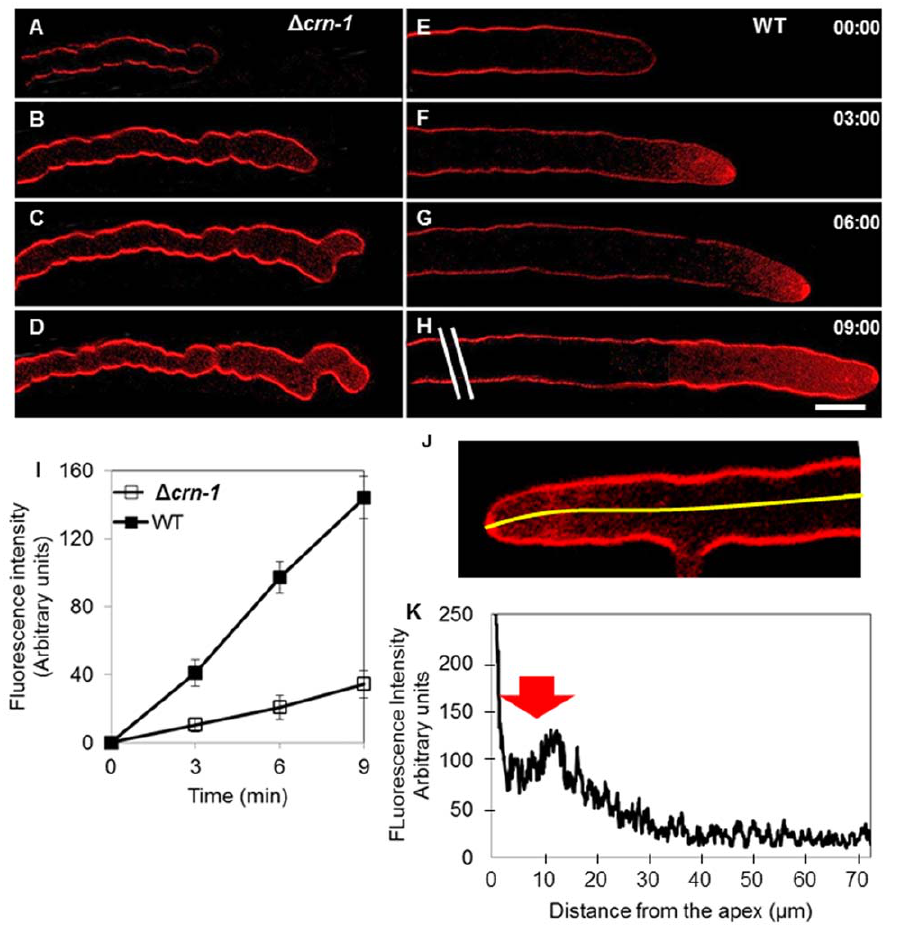
Figure 6. Comparative rates of internalization of the endocytic marker FM4-64. (A–D) D crn-1 mutant and (E–H) WT (I) Graph of fluorescence intensity in a subapical cytoplasmic region (10 m m from the tip; the area measured averaged 50 pixels) in the D crn-1 mutant (n=30) and the WT (n=30). (K) Graph of fluorescence intensity along the first , 70 m m (yellow line) from the apex of the WT hypha shown in J (n=10). Arrow points to the endocytosis region. Time in min:sec. Scale bar=10 m